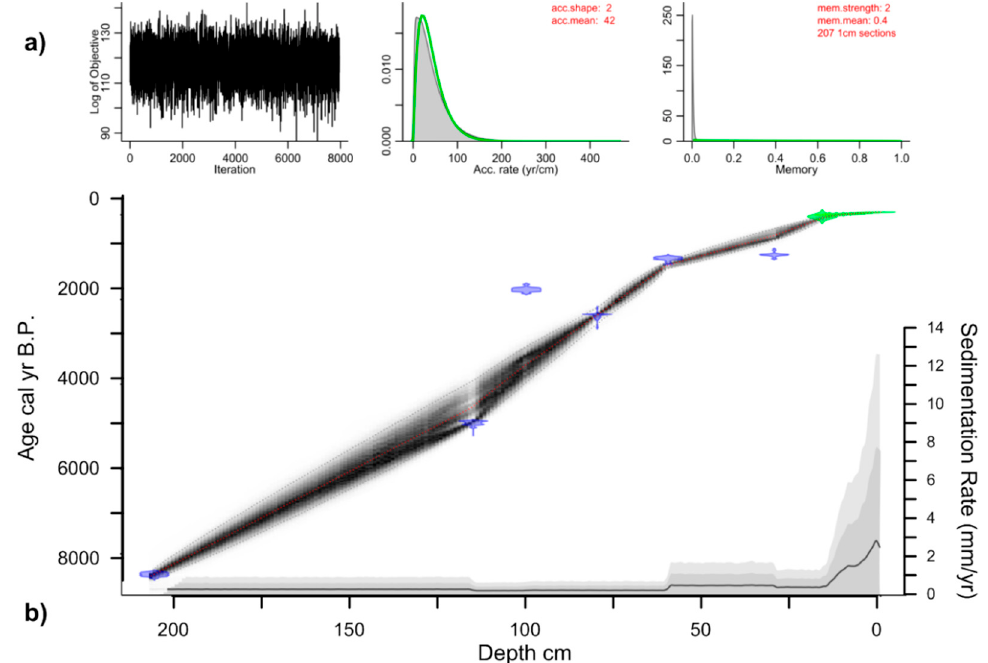
Figure 2. Lake Caranã 210 cm sediment core age–depth model [41,42]. ( a ) Markov chain Monte Carlo iterations from BACON ( top left ) and priors (green curves) and posteriors (gray histograms) for accumulation rate ( top middle ) and memory ( top right ). The age model iterations (black hatching) are based on radiocarbon ages (blue probability density functions) and 210 Pb ages (green probability density functions), with model mean (red dashed) and 2 σ (black dashed) distributions. ( b ) Accumulation rates from the sediment core. Modified from Maezumi et al. [41,42].